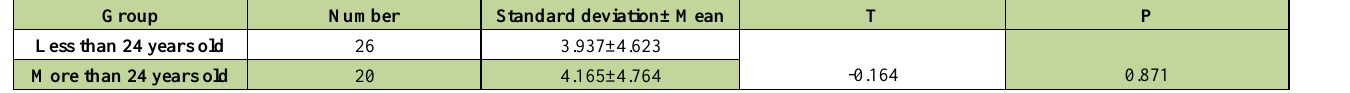
Table4. Comparison of mean difference of second period index plaque between two age groups.